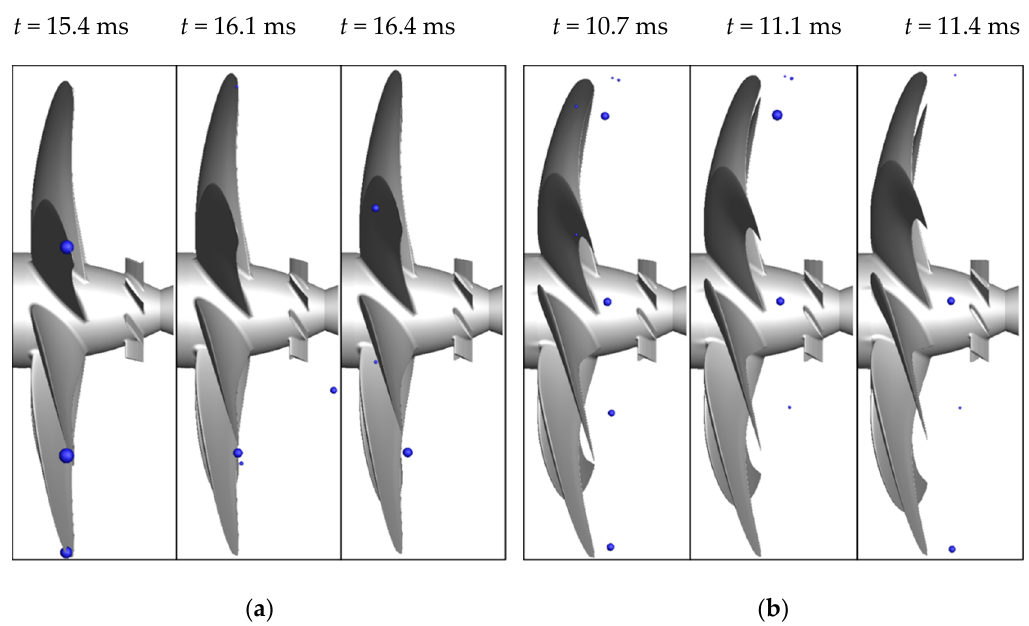
Figure 20. Predicted tip vortex cavitation flow field for ( a ) Model-A and ( b ) Model-B.